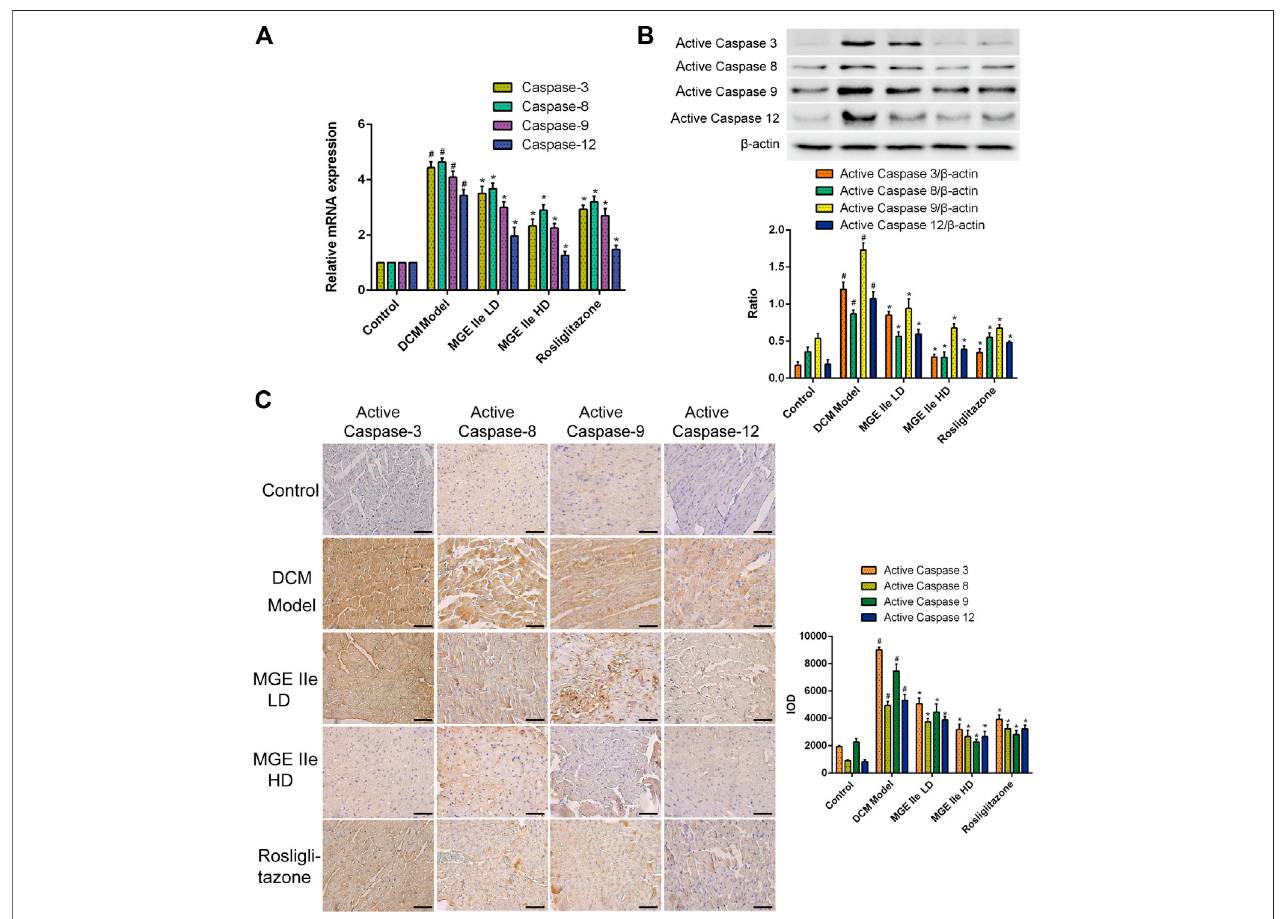
FIGURE 2 | MGE IIe inhibits the expression of apoptotic factors of the caspase family. (A) MGE IIe inhibited mRNA expression of caspase-3, -8, -9, and -12 as assessed by qPCR assay. (B) MGE IIe suppressed the activity of caspase-3, -8, -9, and -12 as revealed by western blot assay. (C) MGE IIe suppressed the activity of caspase-3,-8,-9,and-12asrevealedbyIHCassay.Bar (cid:2) 50 µm.One-wayANOVA wasfollowedbyposthoctests forcomparisonsamonggroups. Thevaluesshown representthemean ± standarderrorofthemean(SEM)ofthedatafromthreeindependentexperiments. # p < 0.05(comparedtothecontrolgroupalone);* p < 0.05 (compared to the model group